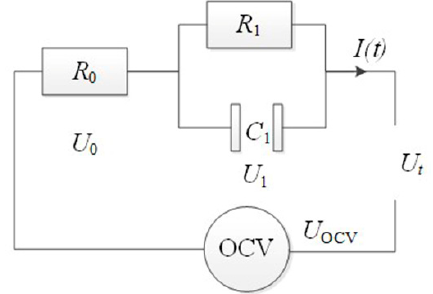
Figure 1. The Thevenin model for a lithium-ion cell.